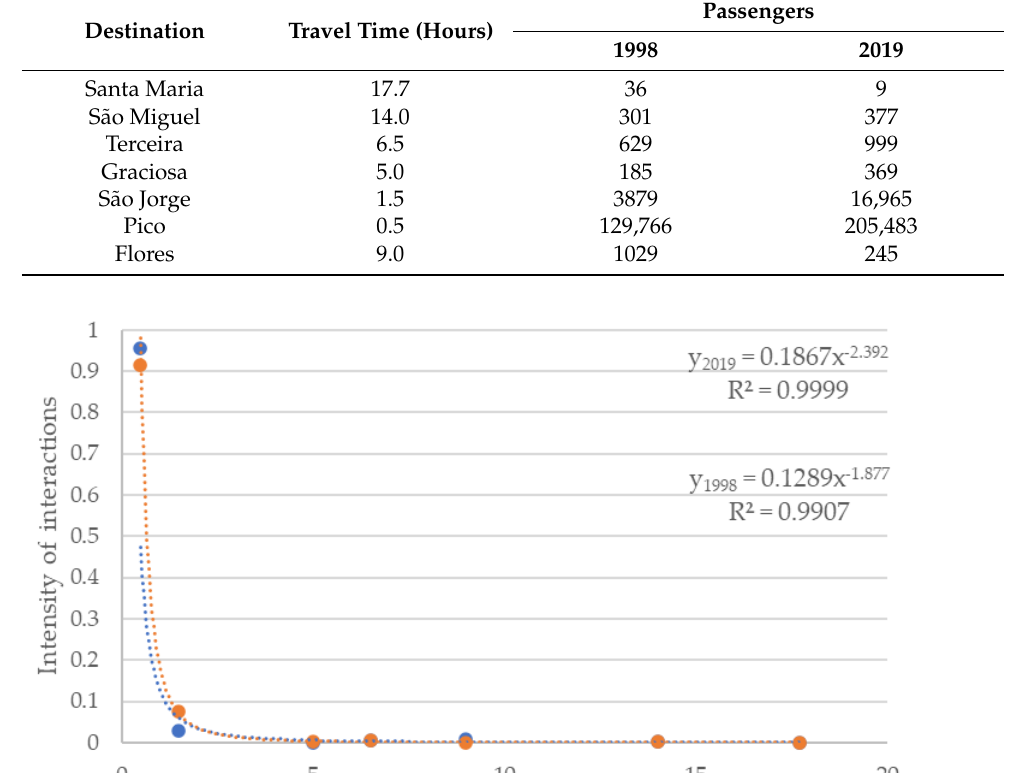
Table 1. Data for maritime connections to Faial Island from the rest of the archipelago — for 1998 and 2019.